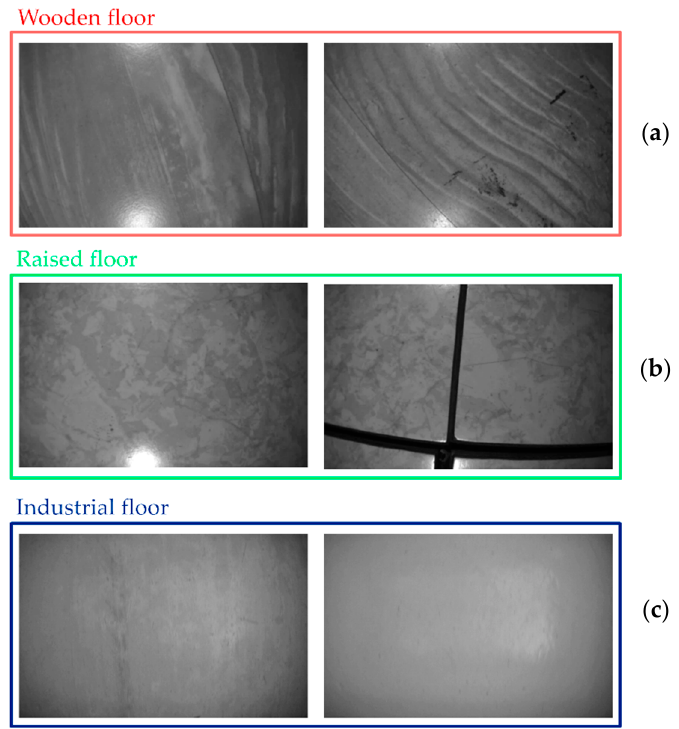
Figure 10. Some images captured by the camera related to the ( a ) wooden floor, ( b ) raised floor and ( c ) industrial floor. The industrial floor presents low (on the left) and very low (on the right) texture.